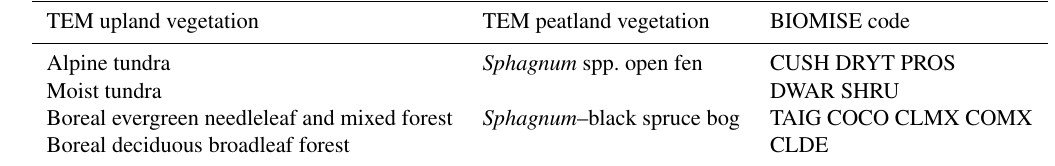
Table 3. Assignment of biomized fossil pollen data to the vegetation types in TEM (He et al., 2014). TEM upland vegetation